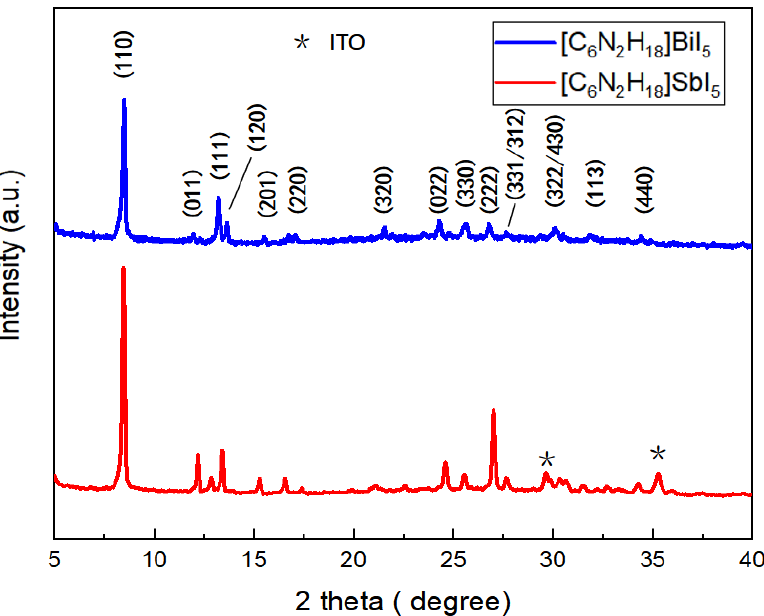
Figure 1. X-ray diffraction spectrum of single organic–inorganic hybrid ferroelectric materials. Where * is the diffraction peak of the ITO material.